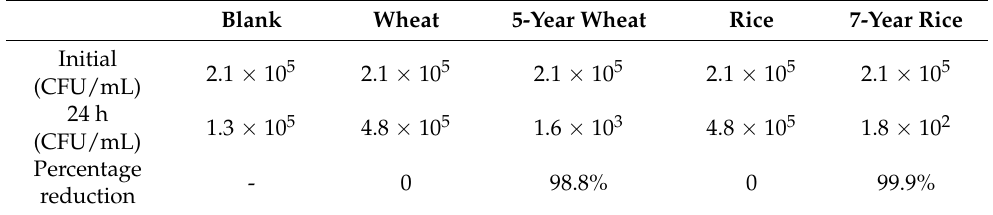
Figure 2. Antibiosis experiments on fresh wheat starch, 5-year fermented wheat starch, fresh rice starch and 7-year fermented rice starch. Table 3. Antiseptic properties of fresh wheat starch, 5-year fermented wheat starch, fresh rice starch and 7-year fermented rice starch.